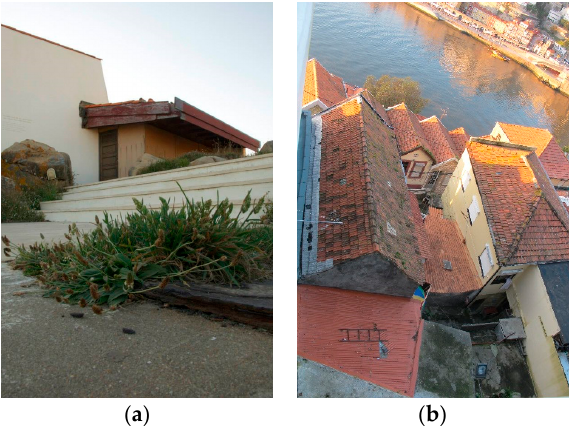
Figure 1. ( a ) Photograph of the Boa Nova Tea House by Architect Siza Vieira; ( b ) Photograph of the Historic Center of Porto.